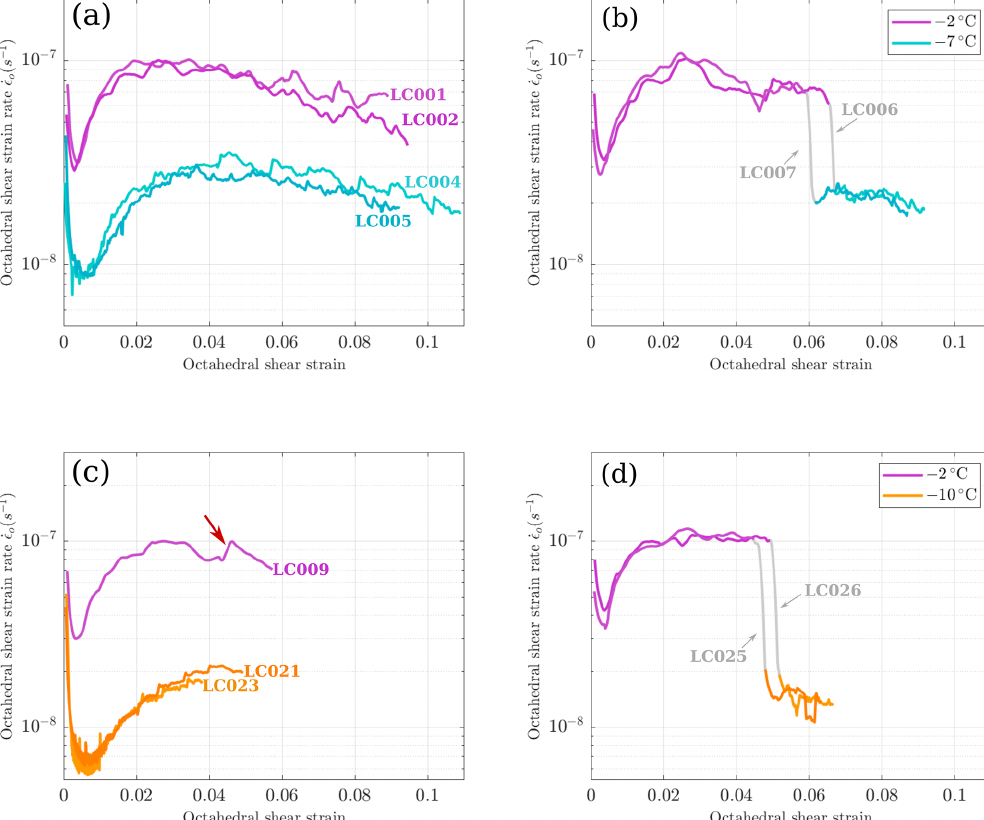
Figure 3. Smoothed octahedral shear strain rate data plotted against total accumulated octahedral shear strain for all experiments. (a, c) Constant-temperature experiments. (b, d) Changing-temperature experiments. The red arrow indicates an example of a strain rate jump as described in Sect.